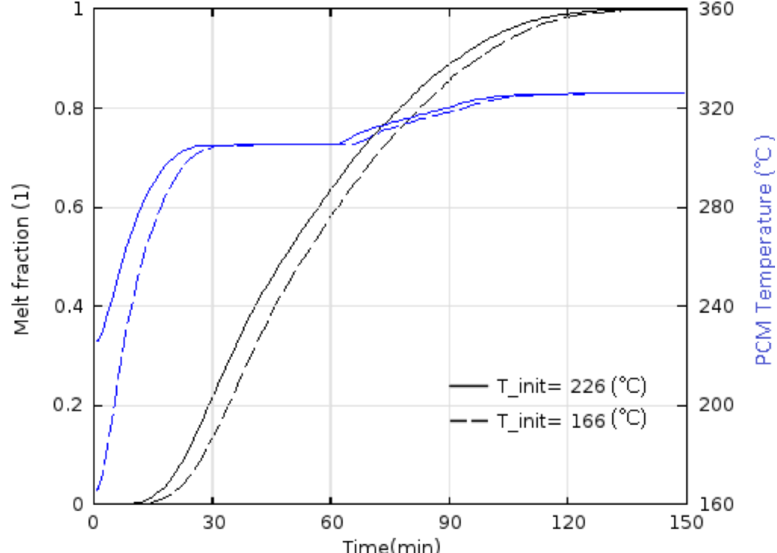
Fig. 5. PCM temperature at z/L = 0.6 and melt fraction of the bed for two different initial conditions as a function of